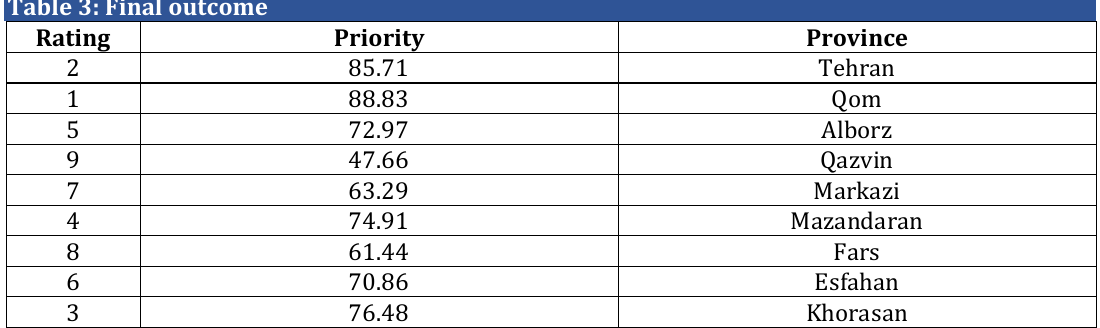
Table 3: Final outcome